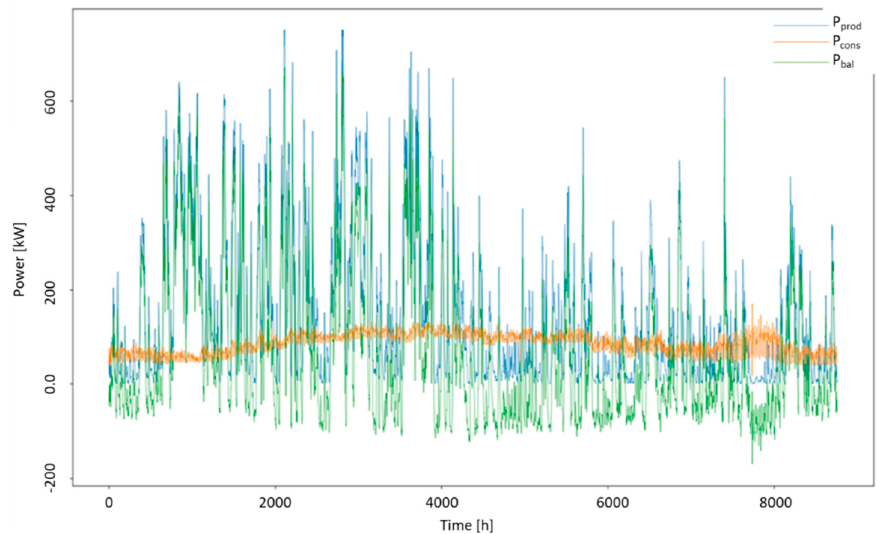
Figure 11. Power production, Power consumption and difference between the two (Power balance), in KW for 2016, 2 Weptos configuration.